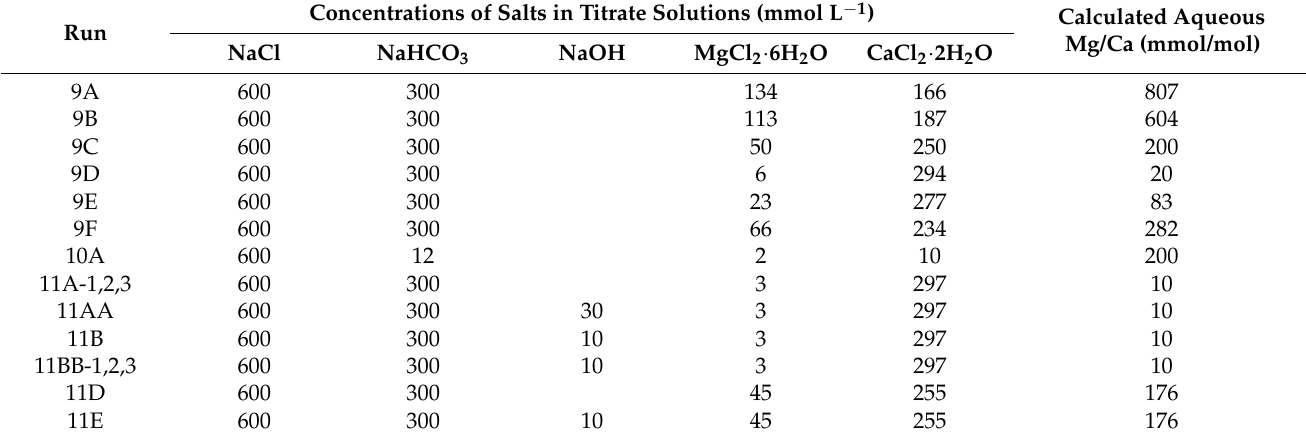
Table 1. Concentrations of salts in the titration